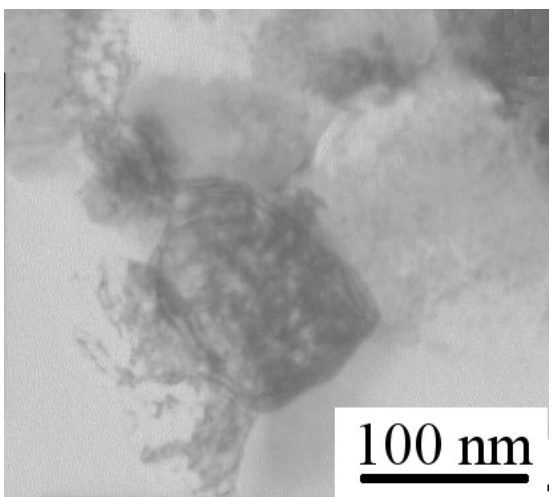
Figure 2. The TEM micrograph of the material after ECAP.